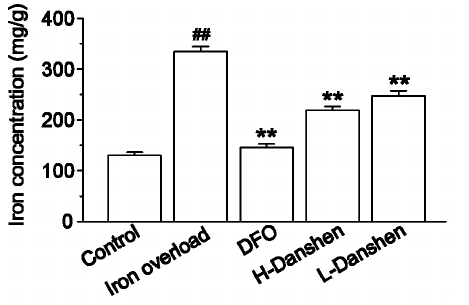
Figure 5. Effects of Danshen injection on iron levels in kidney homogenates. Iron levels were measured in kidney homogenates of control, iron overload, DFO, H-Danshen and L-Danshen groups. Data are presented as means 6 S.E.M of 15 animals per group. **P , 0.01, compared with iron overload group; ## P , 0.01, compared with control